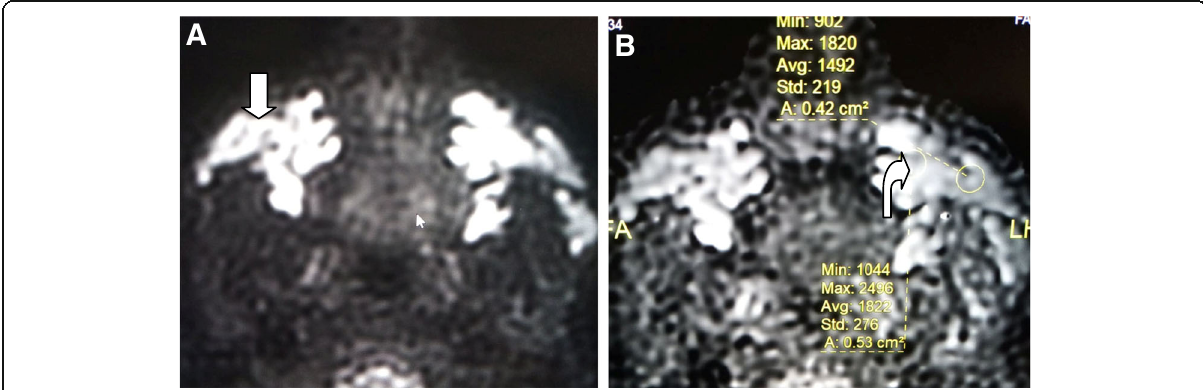
Fig. 6 A 46-year-old female patient with history of lymphoma on remission, subjected to routine follow-up. DWI ( a ) and corresponding ADC map ( b ) showing facilitated diffusion on the medial and middle superficial cheek fat compartment with mean ADC value 1.4 × 10 − 3 mm 2 /s excluding possibility of lymphomatous infiltration (open arrow in a , curved arrow in b